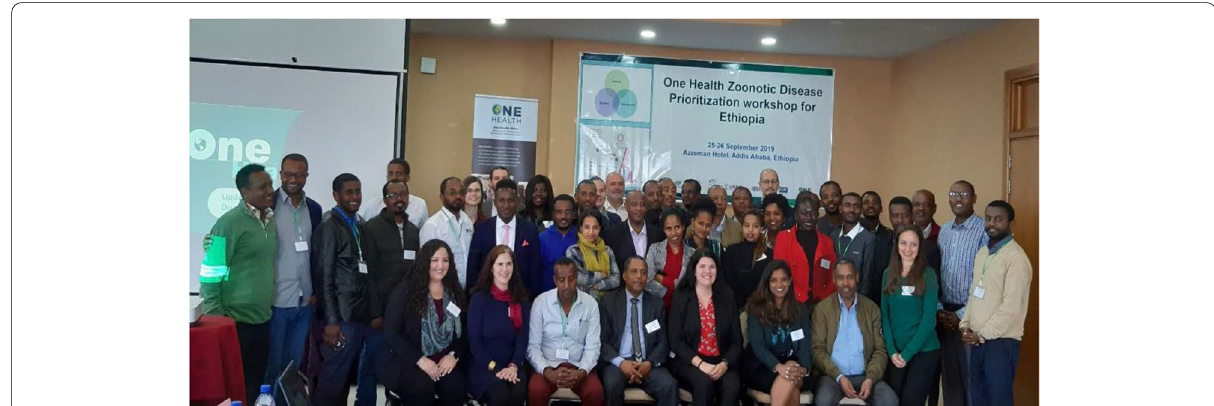
Fig. 8 Participants of One Health zoonotic disease re-prioritization workshop in Ethiopia, Photo taken from the workshop by the first